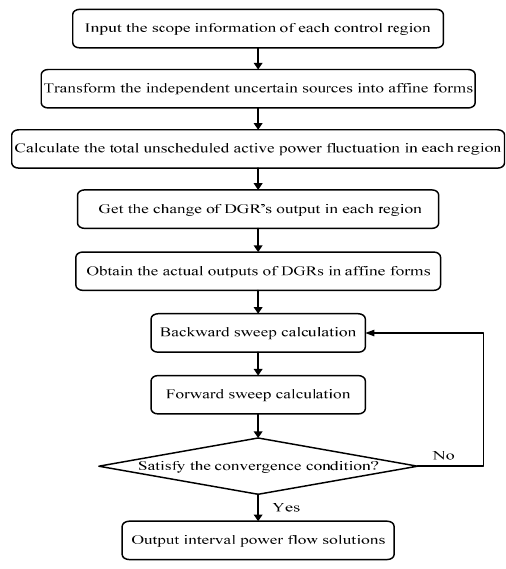
Figure 2. Flowchart of the proposed algorithm.